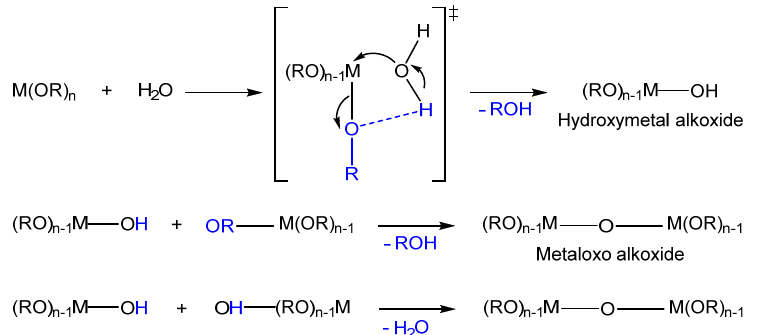
Figure 1. Schematic representation of the formation of oligomeric alkoxides via oxygen bridging. Depending on whether one or more types of metal cations are involved in the corre- sponding alkoxides, compounds are referred to as homometallic or heterometallic alkoxides, both of which [28] are highly reactive compounds due to the strongly polarized M δ + -O δ − -C bond, and, consequently, require handling under inert conditions. Whereas the oxygen atom is likely to react with electrophilic reagents, the metal center is prone to nucleophilic attack, for example, by water, whereby the reaction follows a complex sequence of hy- drolysis and condensation reactions (Scheme 1) [29]. During the hydrolysis, the alkoxide groups are either replaced by hydroxo (OH − ) or oxo (O 2 − ) ligands. In the presence of sufficient amounts of water and x ≤ 2, other nucleophilic attacks of water take place. Sub- sequently, the M-O-M chain is prolonged, and the sol–gel process starts. In excess water, the simultaneous nucleophilic attack of water on all alkoxy groups takes place and leads to the formation of solvated metal hydroxides. The final product of the hydrolysis is the formation of complex oxidic or typically amorphous hydroxy-based solids.